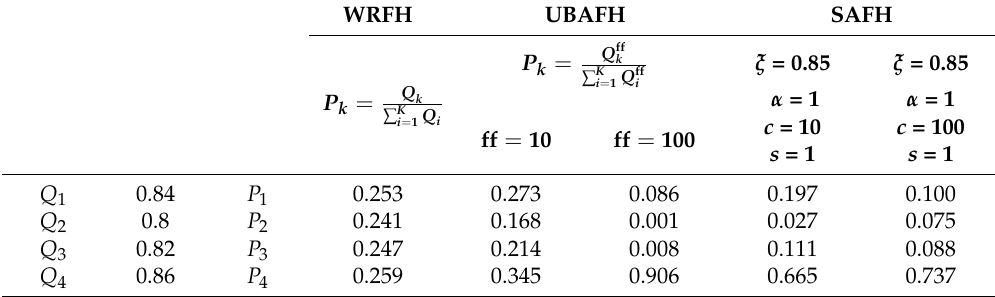
Table 1. Comparison of channel usage for Weighted Random Frequency Hopping (WRFH), Utility Based Adaptive Frequency Hopping (UBAFH) and Smooth Adaptive Frequency Hopping (SAFH)